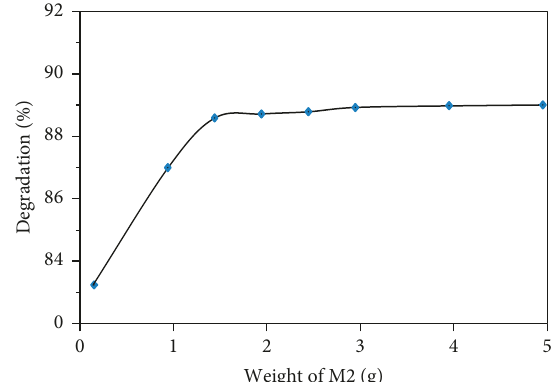
Figure 10: The effect of the amount of mixed material M2 on the degradation percentage of